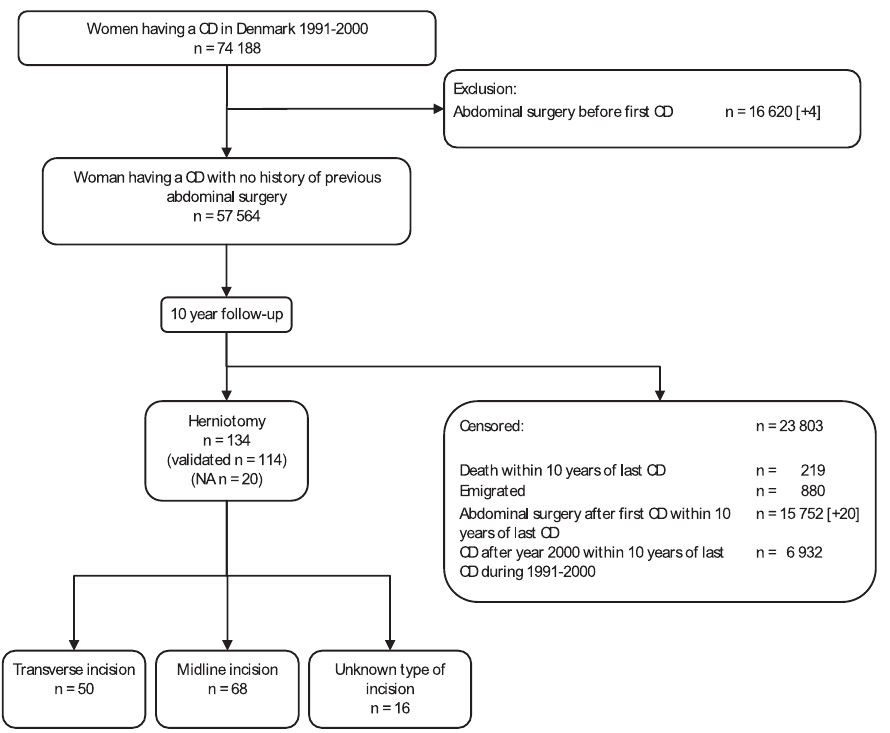
Figure 1. Flow through the study. Number in brackets is number of excluded and censored cases found through validation. CD: cesarean delivery. NA: Not available.